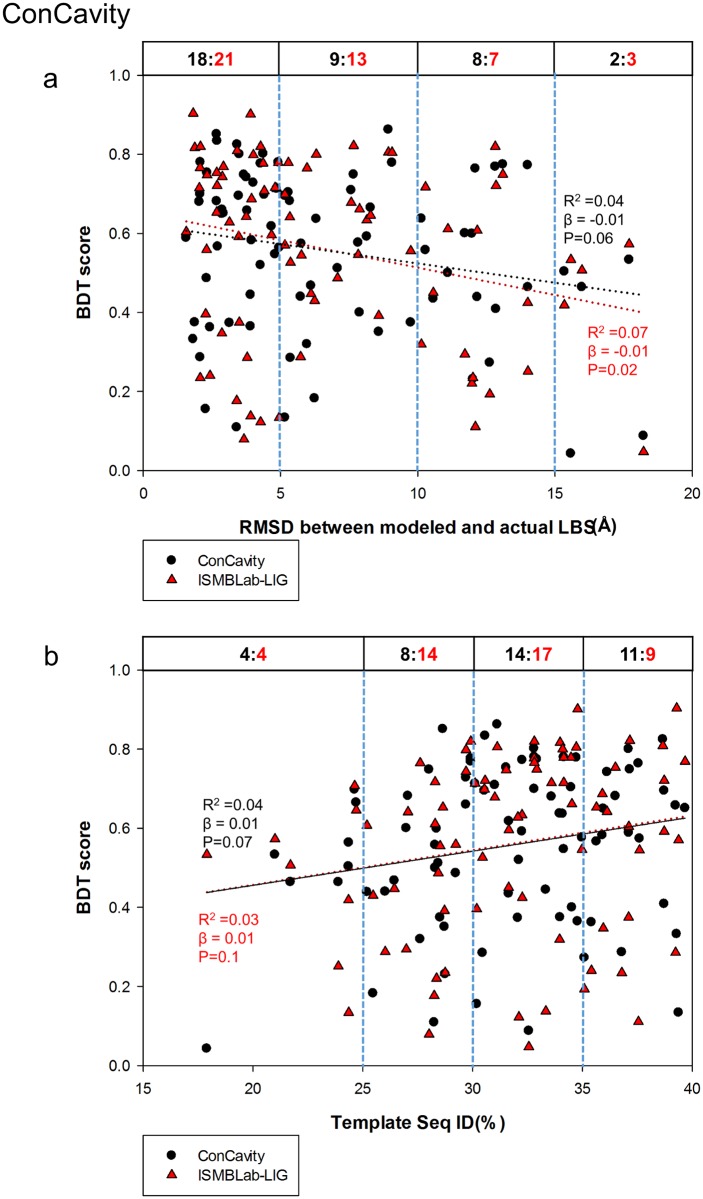
Comparison of ISMBLab-LIG and ConCavity predictions.See description in Fig 6.